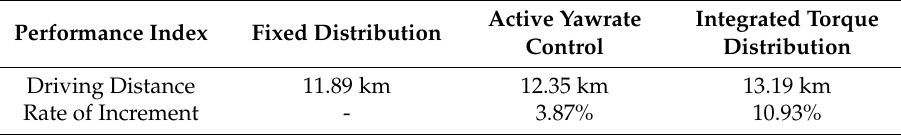
Figure 15. Simulation results of battery SOC for complex driving road. Table 2. Simulation results of efficiency.